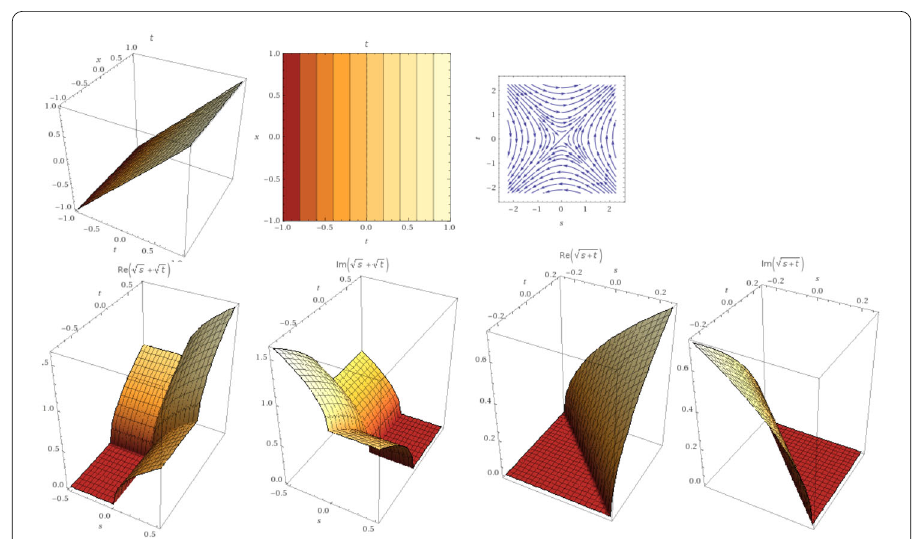
Figure 3 GB for the linear case. From the left: the graph represents 3D solution, contour plot, and integral curve. Similarly, for the case ( τ , ς ) for all real coefficients. The second row is GB of fractional order μ = 0.5, which indicates the set { ς , τ ,